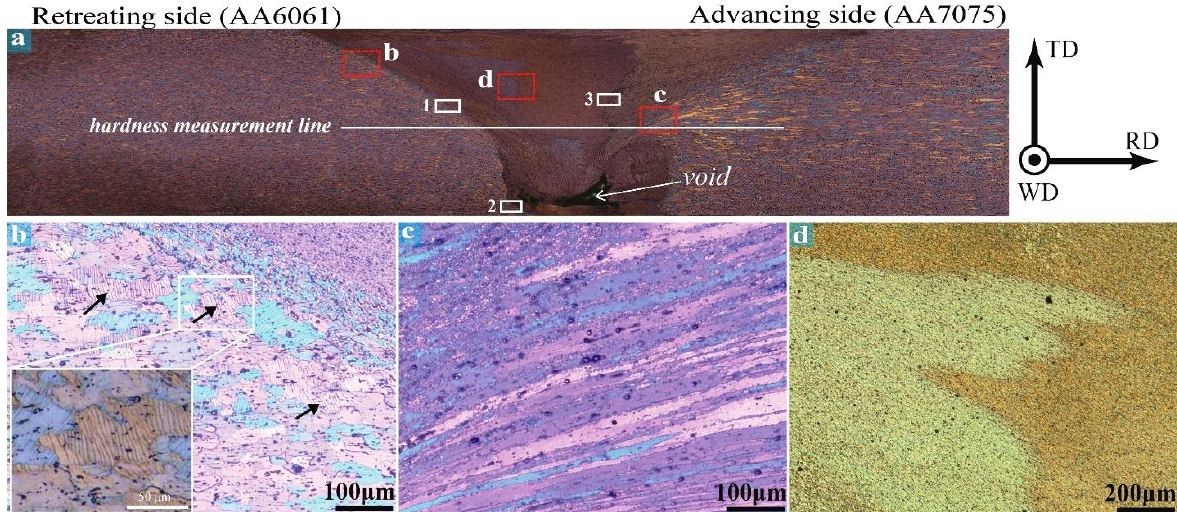
Figure 2. ( a ) Cross-sectional macrostructure of the joint. ( b – d ) the microstructures of the areas identified in ( a ): ( b ) grain subdivision in TMAZ of AA6061 (the inset image in left-bottom corner is an enlarged view of the area identified by white rectangle); ( c ) elongated large grains in TMAZ of AA7075 without subdivision process; ( d ) the interfacial area at the center of the joint. White rectangles (1-3 numbered) refer to the EBSD scan areas. The white line belongs to the hardness measurement line. The white arrow refers to a void formed in the cross-section of the joint.